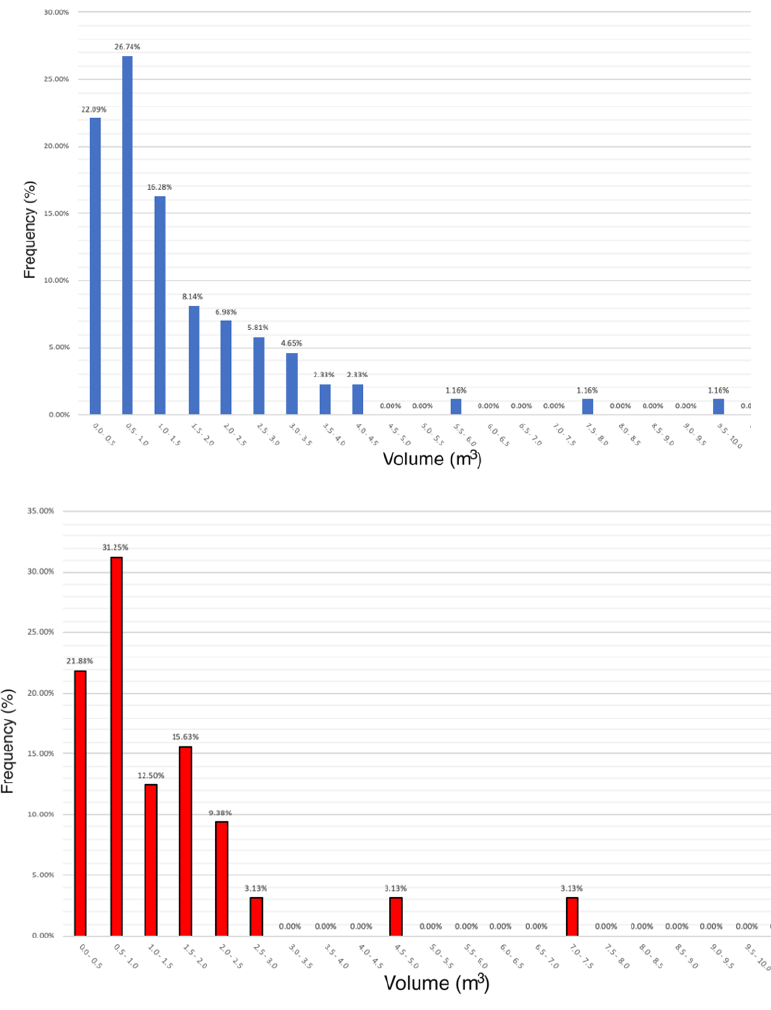
Figure 15. Volume distribution for both the fallen (blue) and the potentially unstable (red) blocks for sub-region U1.